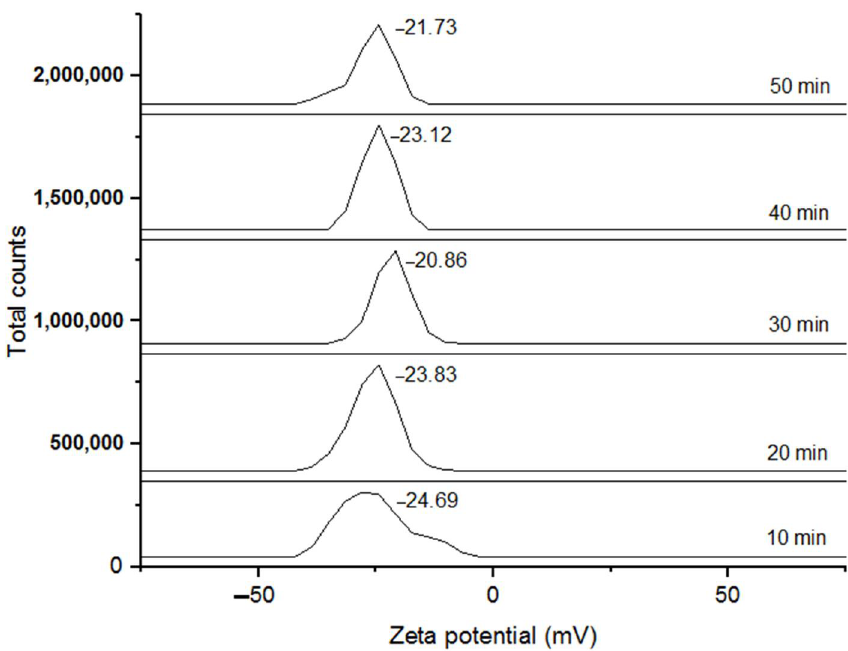
Figure 5. Zeta potential measurements of silver nanoparticles at different synthesis times.